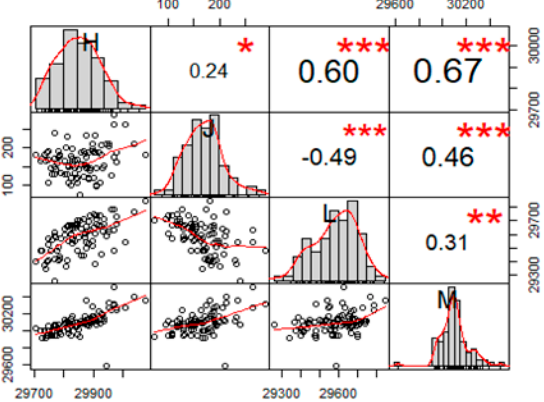
Figure 2. Intercorrelations between the path-performance metrics average-best , stddev-best , best try and worst try for fl3795 . 5.4. Discussion on Behaviour of Adapted MMAS with TSP Instance rl1889 The optimum for TSP instance rl1889 is 316,536. As data in Table 7 (except line no. 17) display, the relative error for the 18 variants of MMAS with ampl = 40 is placed in the interval [0.49, 0.69], corresponding to an absolute error ( distance-to-optimum in the file rl1889 ) in the interval [1565.4, 2184.6]. For this instance, the relative error is very small also, as it is for d2103 . We note that the